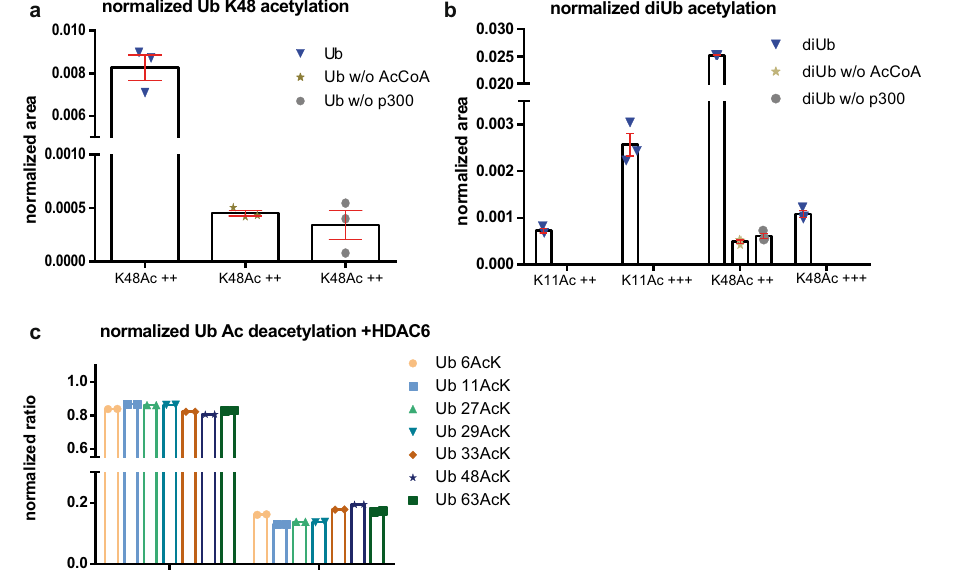
Fig. 7 | Acetylation and deacetylation of Ub / Ub AcK variants by p300 and HDAC6,respectively.a MonomericUbisacetylatedatK48byp300inpresenceof acetyl-CoA (Ub),while only a background signalcanbe observedin the absenceof either acetyl-CoA (Ub w/o AcCoA) or p300 (Ub w/o p300). b M1-linked Ub dimers areacetylatedatK11andK48byp300inpresenceofacetyl-CoA(diUb),whileinits absence (diUb w/o AcCoA) or in the absence of p300 (diUb w/o p300) only back- ground signals are observed. a , b Ub acetylation was normalized against a highly abundant C-terminal peptide of Ub (aa 64 – 73). ++ and +++ indicate doubly and triply protonated charge states of the detected peptide, respectively. For